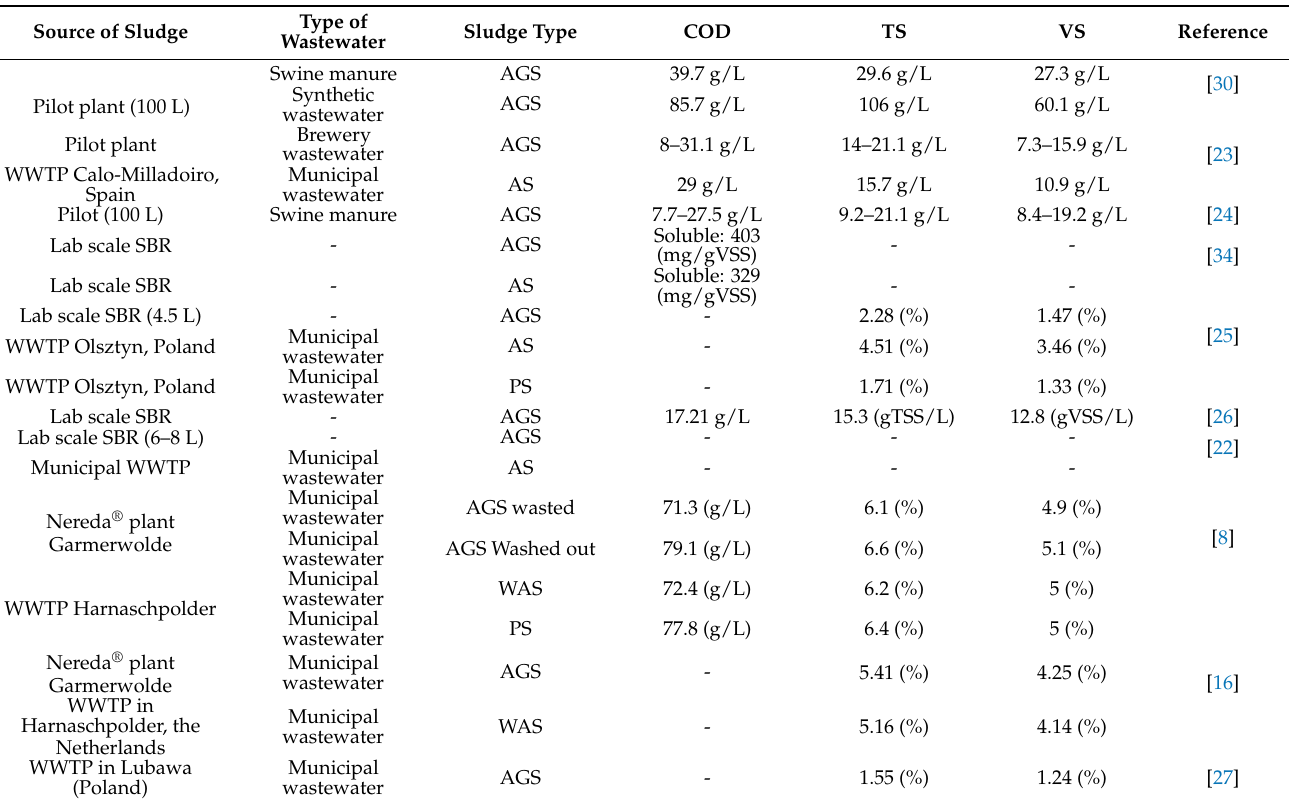
Table 2. Characteristics of AGS and AS from different